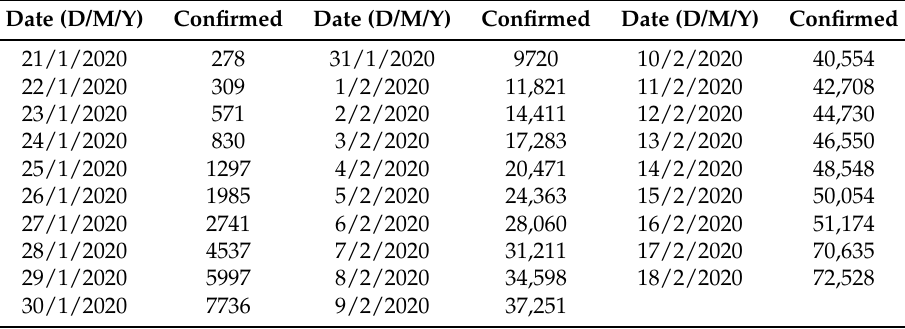
Table 1. The dataset of the